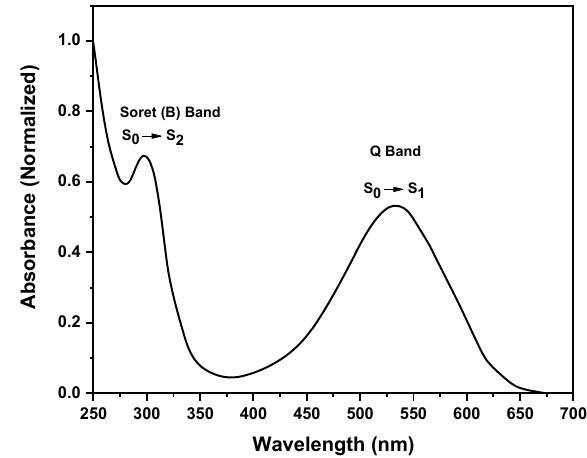
Figure 4. UV–vis absorption spectrum of PAD.